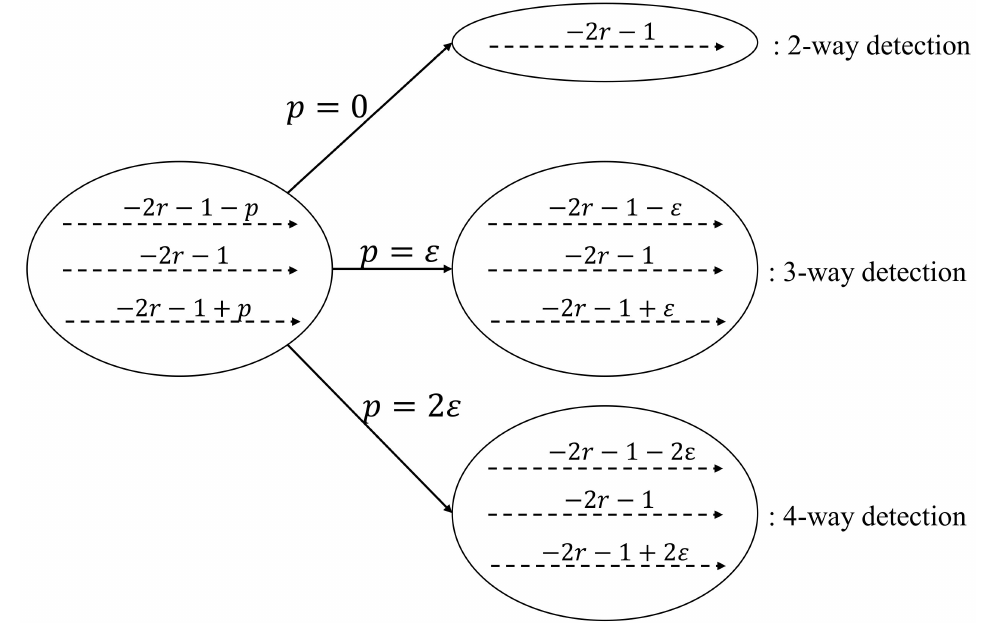
Figure 5. Coefficient p and N-way